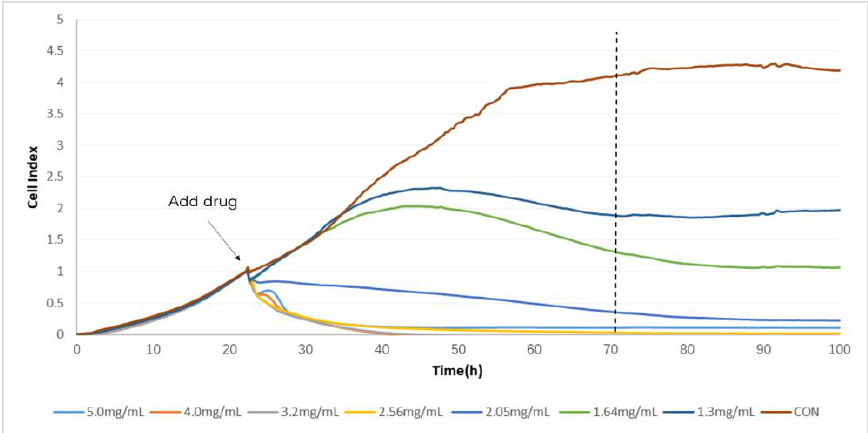
Figure 9. The time/dose-dependent cell response profiles (TCRPs) of the different concentration samples Shanghai Yellow Sea pharmaceutical Compound Danshen Tablets (SYSP-CDT) acting on A549 cells plotted against time with the mean of three experiments. The concentrations are: 5.00 mg/mL (light blue line), 4.00 mg/mL (medium brown line), 3.20 mg/mL (gray line), 2.56 mg/mL (yellow line), 2.05 mg/mL (medium blue line), 1.64 mg/mL (green line), 1.30 (dark blue line), and control (dark brown line).